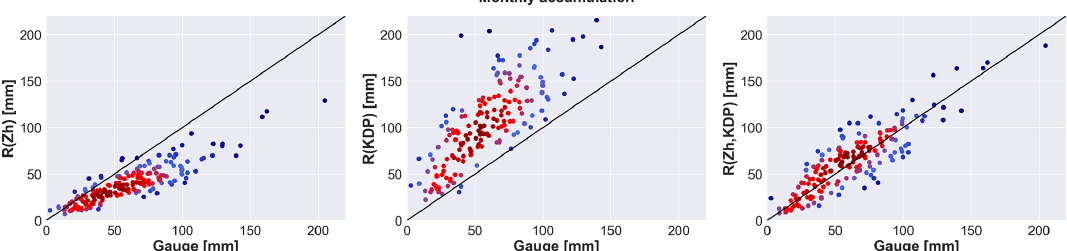
Figure 9. Monthly accumulations for Estonia, 2011–2018. The corresponding verification measures are presented in Table 7. The number of radar–gauge data pairs with eight gauges is 179. Z H is not corrected for attenuation.